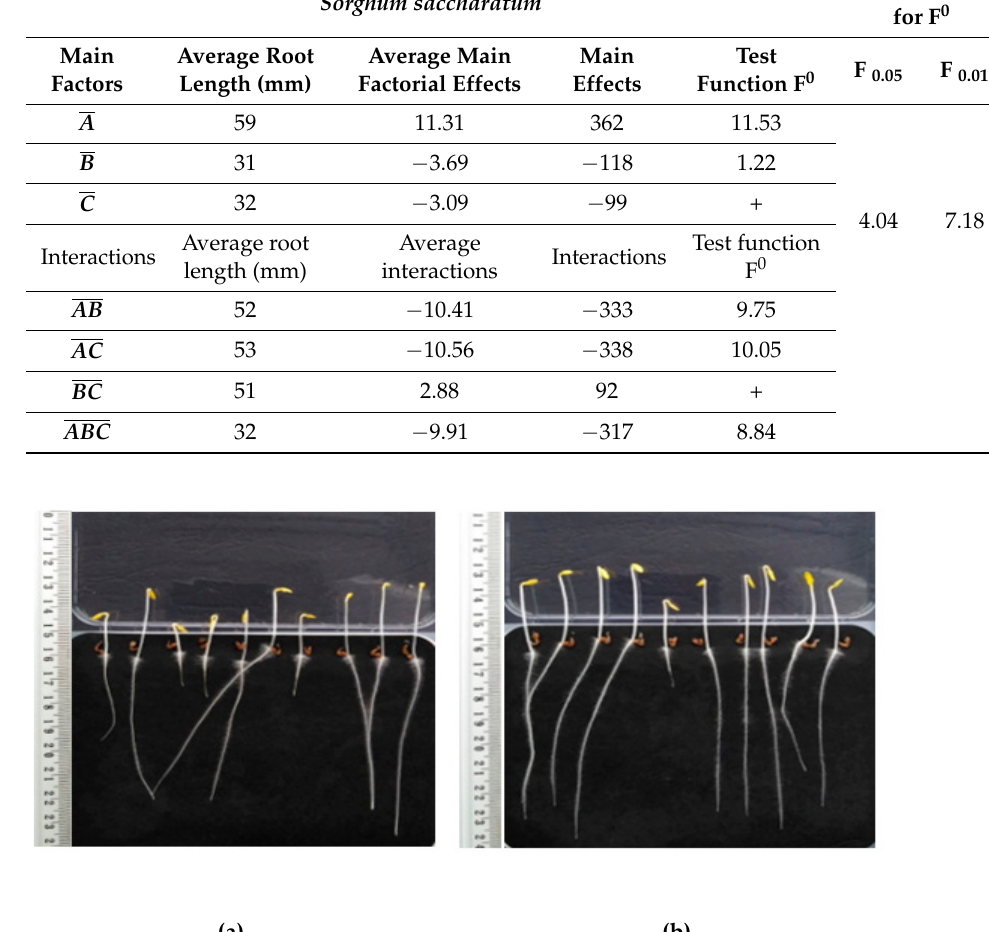
Figure 3. Lepidium sativum after three days of incubation: ( a ) Untreated sample, ( b ) HS fertilization. The mean root lengths, main effects, and interactions calculated for the results of studies conducted with Sinapis alba plants are presented in Table 11. Plants with the long- est roots were fertilized with P (84 mm), HS (82 mm), and HS + P (82 mm). As in the case of Lepidium sativum , a positive effect of HS ( 𝐴 (cid:3365) = 8.02), P ( 𝐶 (cid:3365) = 4.98), and HS + N + P ( 𝐴𝐵𝐶(cid:3364)(cid:3364)(cid:3364)(cid:3364)(cid:3364)(cid:3364) = 3.67) is also observed for Sinapis alba . For mustard, positive and statistically significant main effects of humic substances (factor a) and phosphate fertilizer (factor c) were found at the level of 0.01. The HS + N + P interaction (ABC interaction) is also positive, and the significance level here is 0.05. A negative and statistically significant effect at the level of 0.01 is observed for nitrogen fertilizer (factor b), the combination of HS + P (interaction AC), and N + P (interaction BC). For the HS + N combination (interaction AB), a negative effect is also observed, but it is statistically insignificant. Figure 4 shows Sinapis alba ; specifically, on the left ( a ) are plants with deionized water dosing, and on the right ( b ) are plants treated with HS obtained from digested sludge. Plant samples fertilized with HS have longer roots, but it is worth noting that they also have a much more developed system of lateral roots and hairs. Table 11. Mean main factorial effects, average interactions, and their significance for Sinapis alba. Sinapis alba